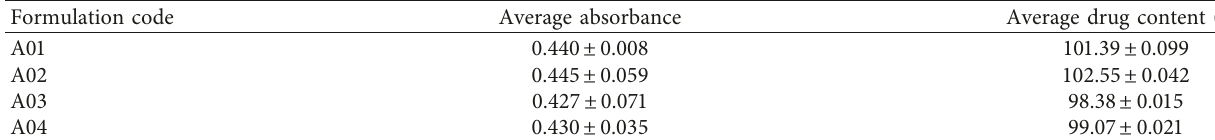
Table 5: Comparative percentage content of Antiaris africana extract in capsules ( n � 3).